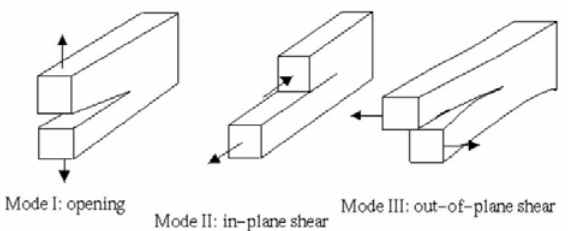
Figure 4. Three loading modes (Avadutala, 2005).